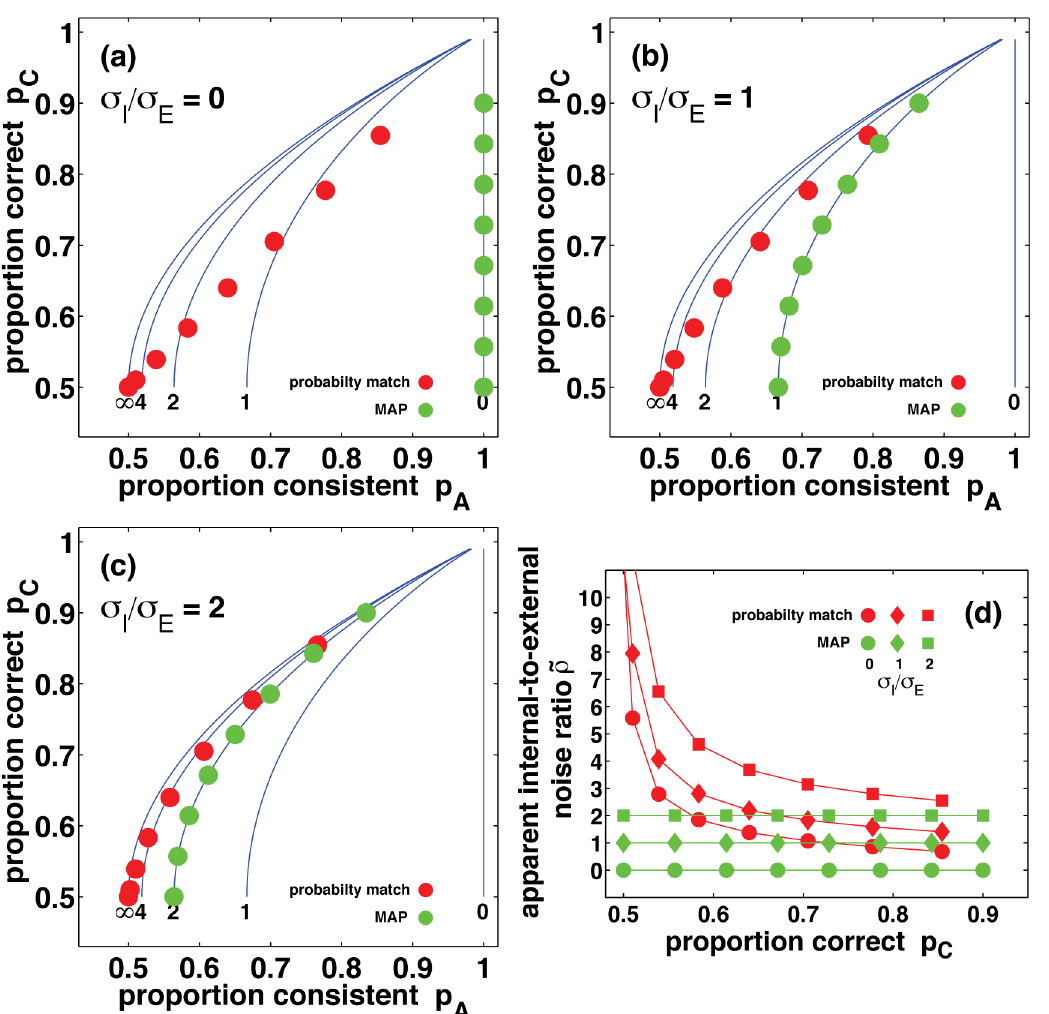
Fig 1. Results from two-pass experiments with model observers. In panels (a), (b), and (c) the filled circles show proportion correct and proportion of consistent responses for simulated internal-to-external noise ratios of 0, 1, and 2, respectively. Red symbols show results for the VPPM observer and green symbols show results for the MAP observer. For reference, blue lines in panels (a), (b) and (c) show the ð p external noise ratios of 0, 1, 2, 4, and the limit where internal noise dominates external noise ( 1 ). Panel (d) replots data from the first three panels, showing the apparent internal-to-external noise ratio as a function of proportion correct. In panel (d), circles, diamonds, and squares show results for simulated internal-to-external noise ratios of 0, 1, and 2, respectively.